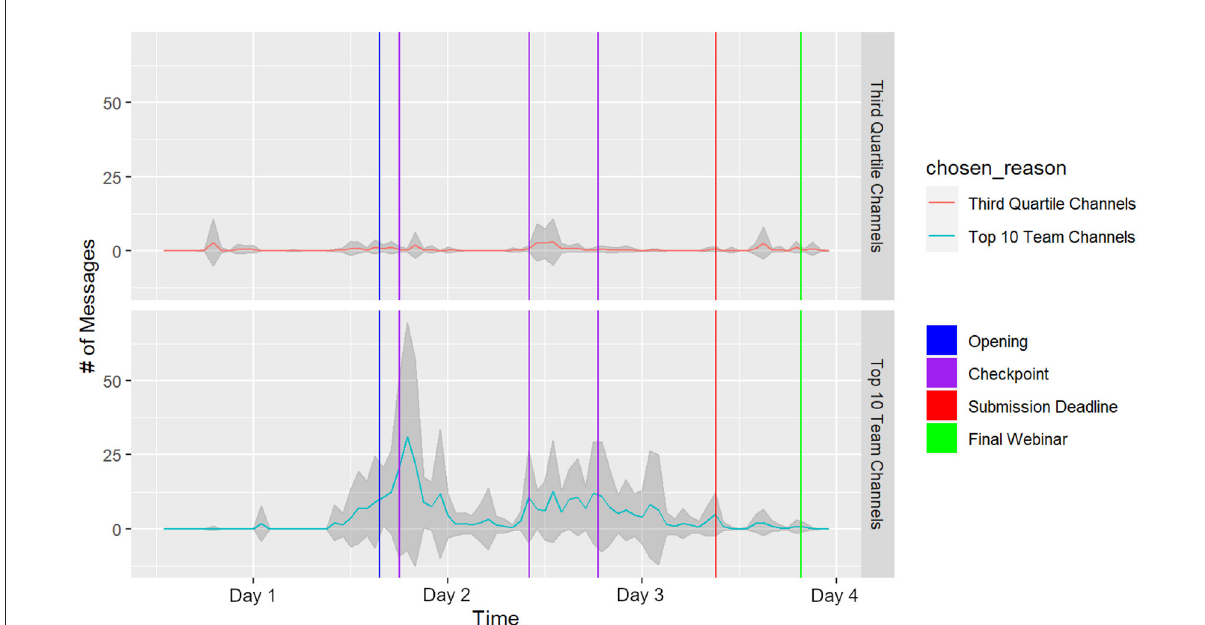
FIGURE3 Messages over time in top 10 team channels vs. 10 team channels around the third quartil abbreviated to the time of the hackathon itself with an additional day before. Solid line indicates average (mean) amount of messages, the gray area shows the standard